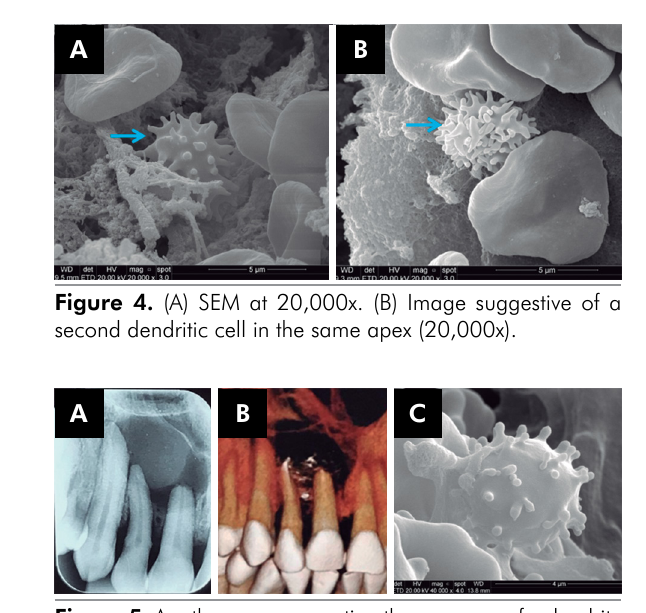
Figure 3. SEM at 5000x demonstrating the presence of neutrophils (A) trapped in the multispecies extraradicular biofilm mesh. (B) SEM at 10,000x.